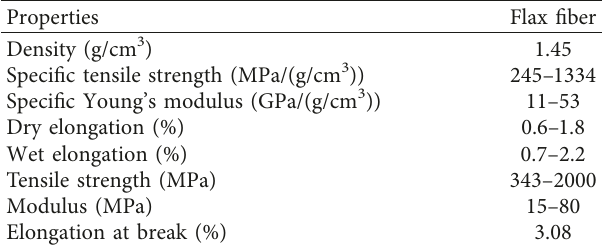
Table 2: Physical and mechanical properties of flax fiber